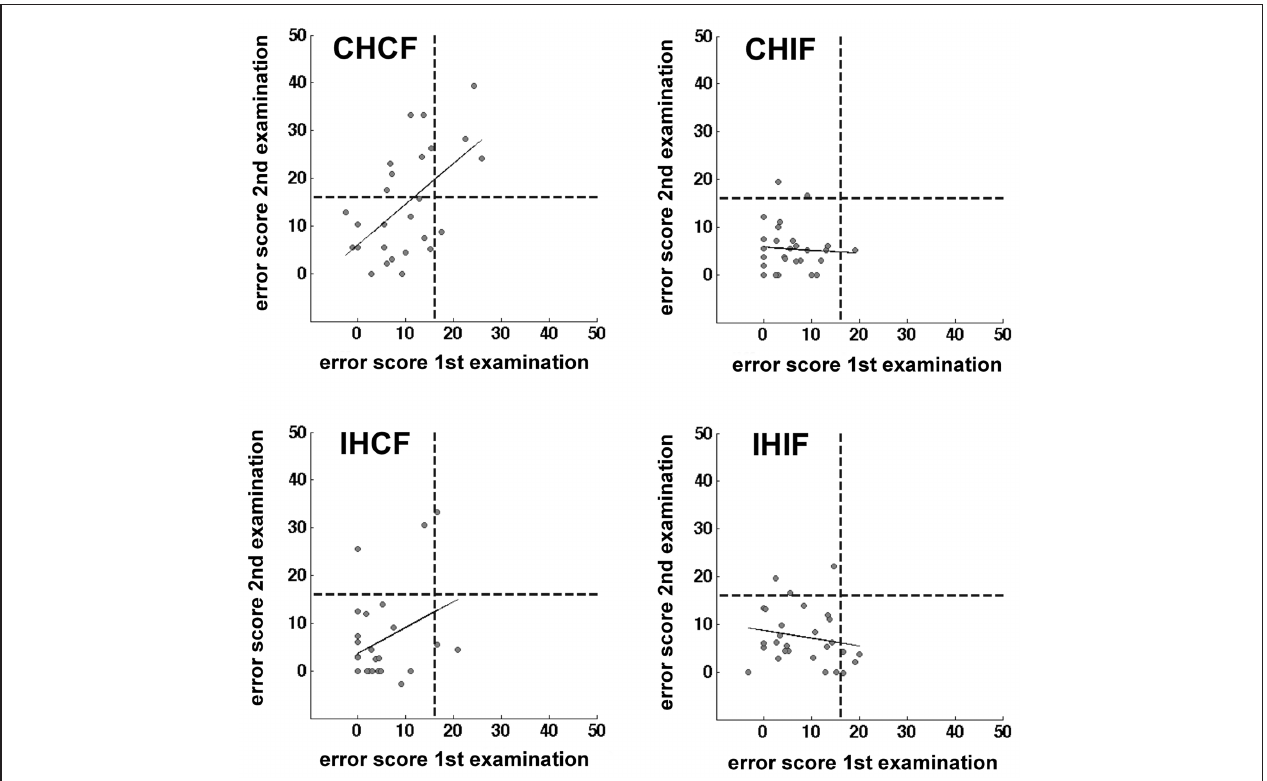
FIGURE 5 | Scatter plots showing the correlation of two test sessions per hand/field combination. Error scores are differences between percentage error scores in the fixation and saccade condition The C&G 0.01 cut-off value is indicated by the black dotted lines. The correlation is indicated by the black